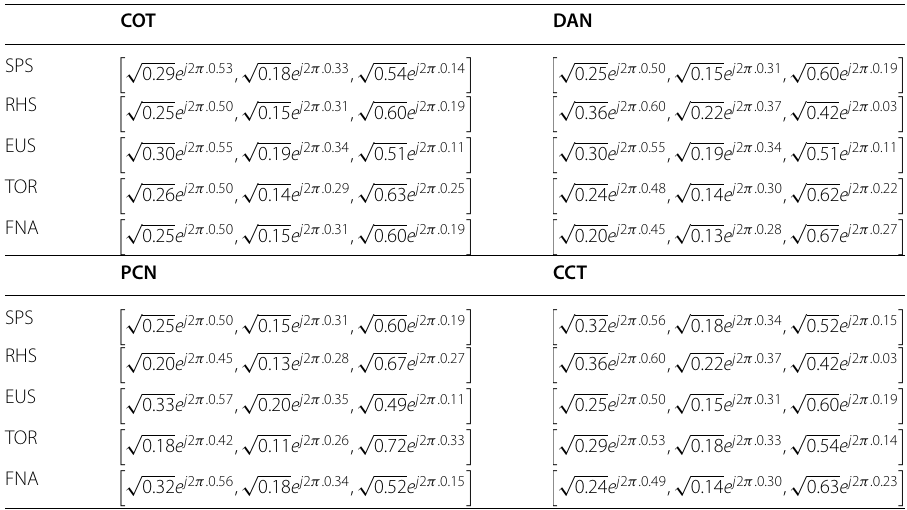
Table 12 Normalized decision matrix for the amplitudes of quantum membership degrees COT SPS